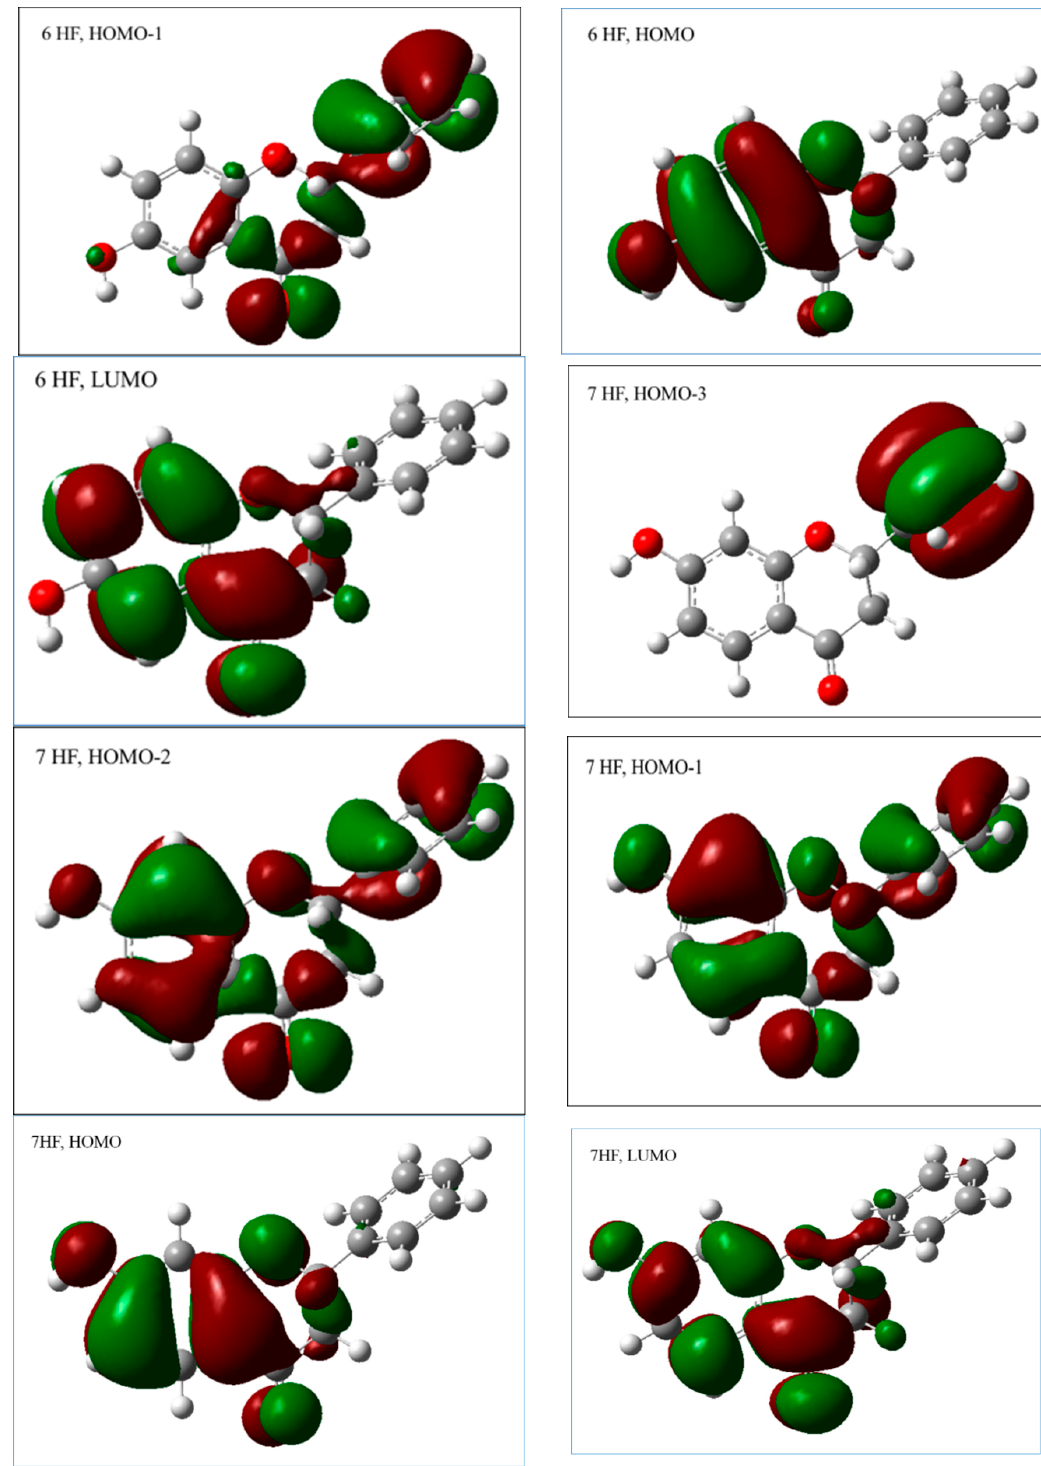
Figure 5. Topologies of molecular orbitals participating in the electronic transitions in the flavanones: F, 2’HF, 6HF and 7HF. (Gaussian 09 and GaussView 5.0.8 Paint/Windows 10; Microsoft Office PowerPoint 2007 software).